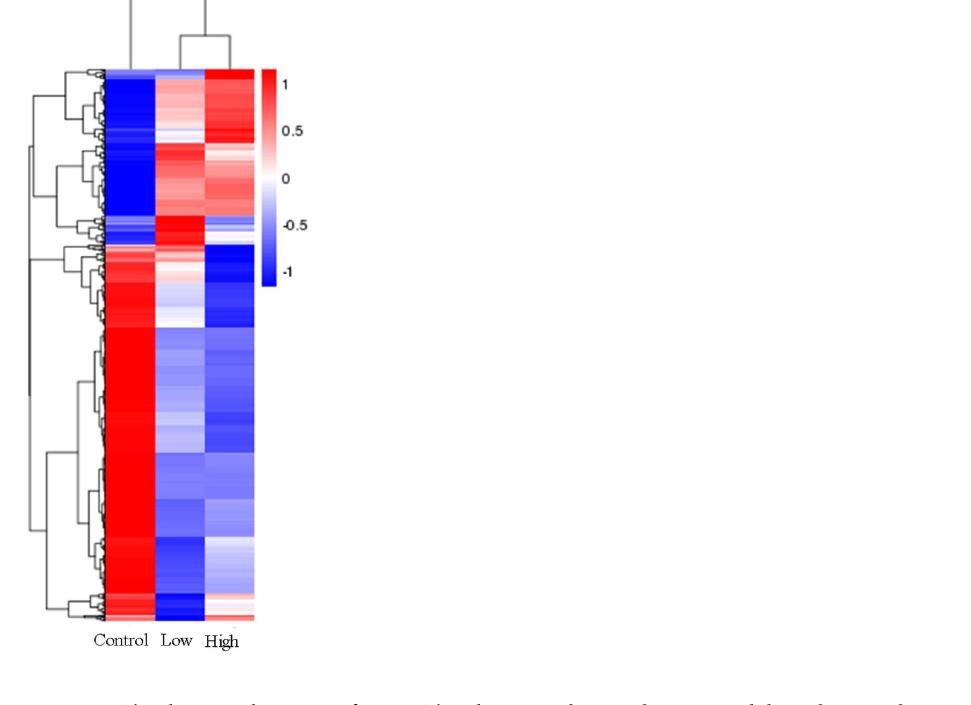
Figure 5. The clustering heat map of DEGs. The Abscissa is the sample name, and the ordinate is the normalized value of the differential gene FPKM. (The redder the color is, the higher the expression is, and the greener the expression is, the lower the expression is).